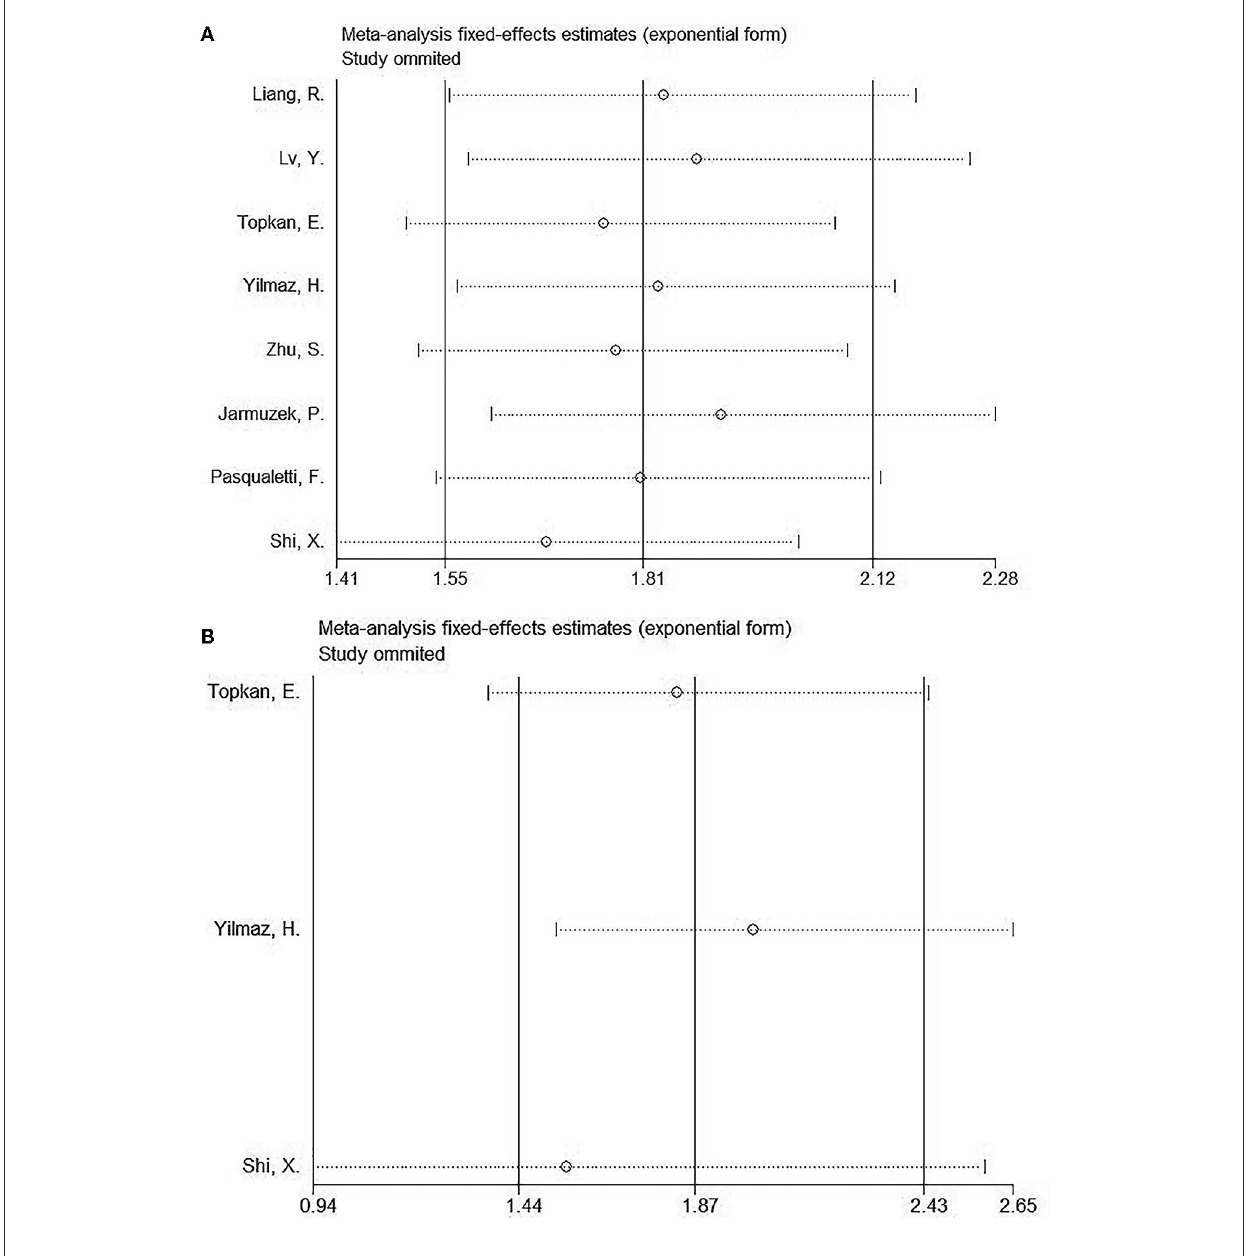
FIGURE4 Sensitive analyses of included studies in this meta-analysis. (A) OS and (B) PFS.